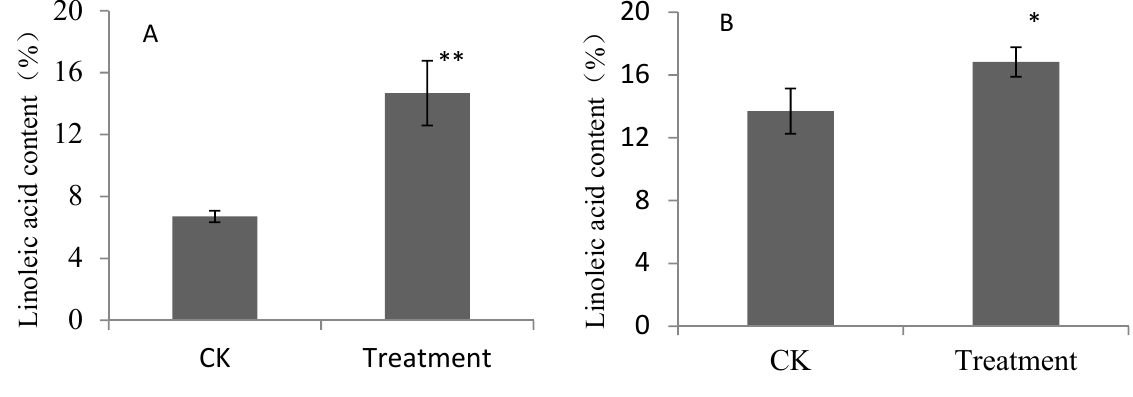
Figure 1. Linoleic acid contents of pear fruits feeding on linoleic acid. ( A) P. bretschnrideri “Dangshansuli”; ( B ) P. ussuriensis “Nanguoli”; Values represented means of three replicates, bars were standard deviation from three replicates; * denoted significant difference between treatments and CK, p < 0.05; ** denoted significant difference between treatments and CK, p < 0.01.